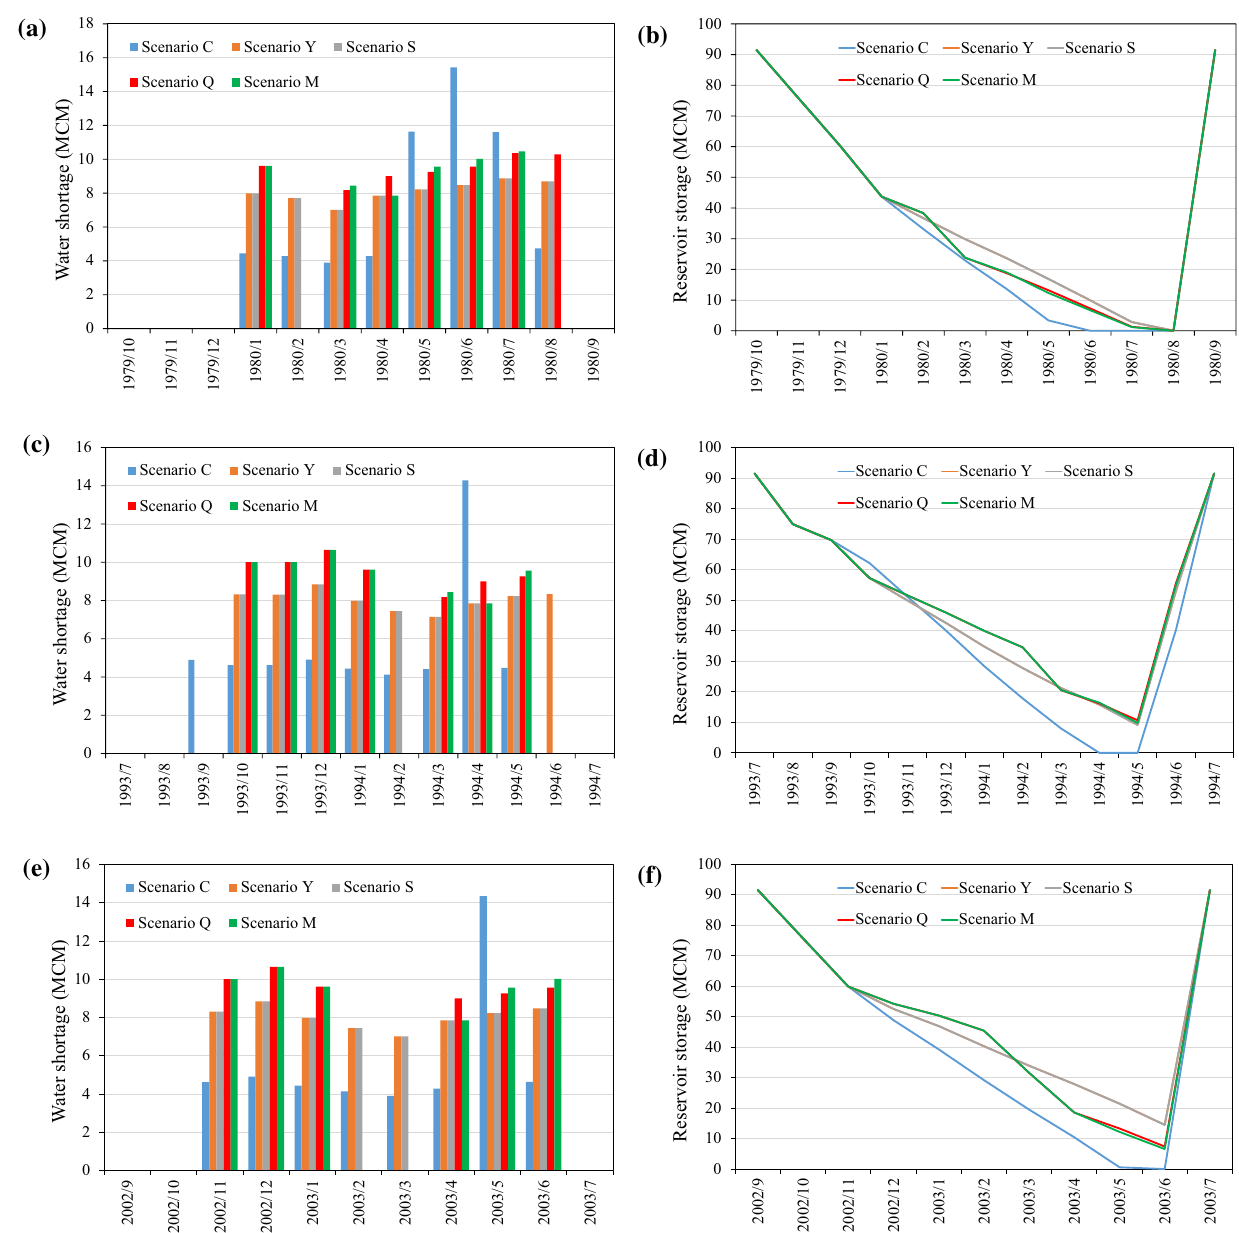
Fig. 5 a , c , e : Water shortages and b , d , f : reservoir storage of various scenarios for 1979–1980, 1993–1994, and 2002–2003,